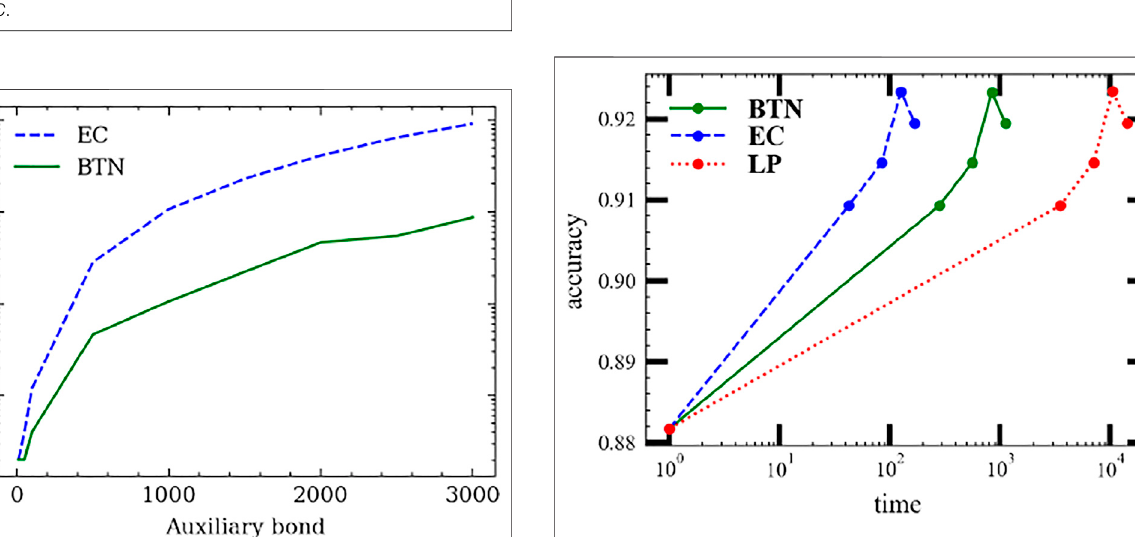
FIGURE 11 | Evaluation of the train accuracy of MPS machine learning tasks on theMNIST dataset using three batch contraction methods:(red solid curve) the batch tensor network method (BTN); (green dashed curve) the ef fi cient coding; and (blue dotted curve) the loop method (LP).